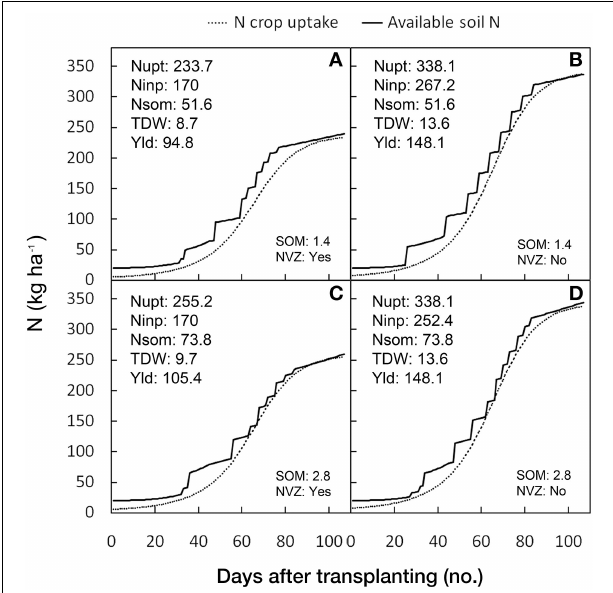
FIGURE 9 | Prevision by GesCoN of N crop uptakes, N application schedules, and N soil availability under four different N scenarios. The simulations were performed with the same soil, climatic and cropping conditions and changing the level of the soil organic matter (SOM) [SOM: 1.4g 100g − 1 , top graphs: (A,B) ; SOM: 2.8g 100g − 1 , bottom graphs: (C,D) ] and the NVZ condition (NVZ: “No,” left graphs; NVZ: “Yes,” right graphs). In each box the simulated total crop N uptake (Nupt, in kg ha − 1 ), total N input (Ninp, in kg ha − 1 ), total N from SOM mineralization (Nsom, in kg ha − 1 ),